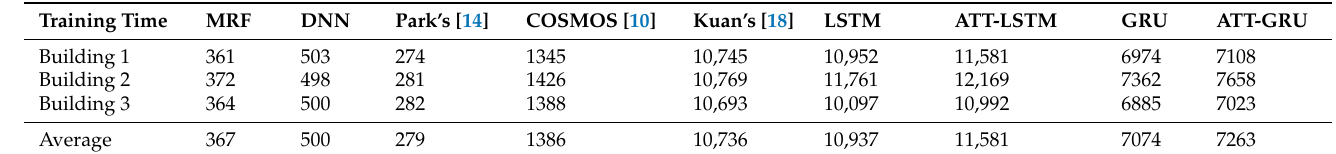
Table 13. Training time of each